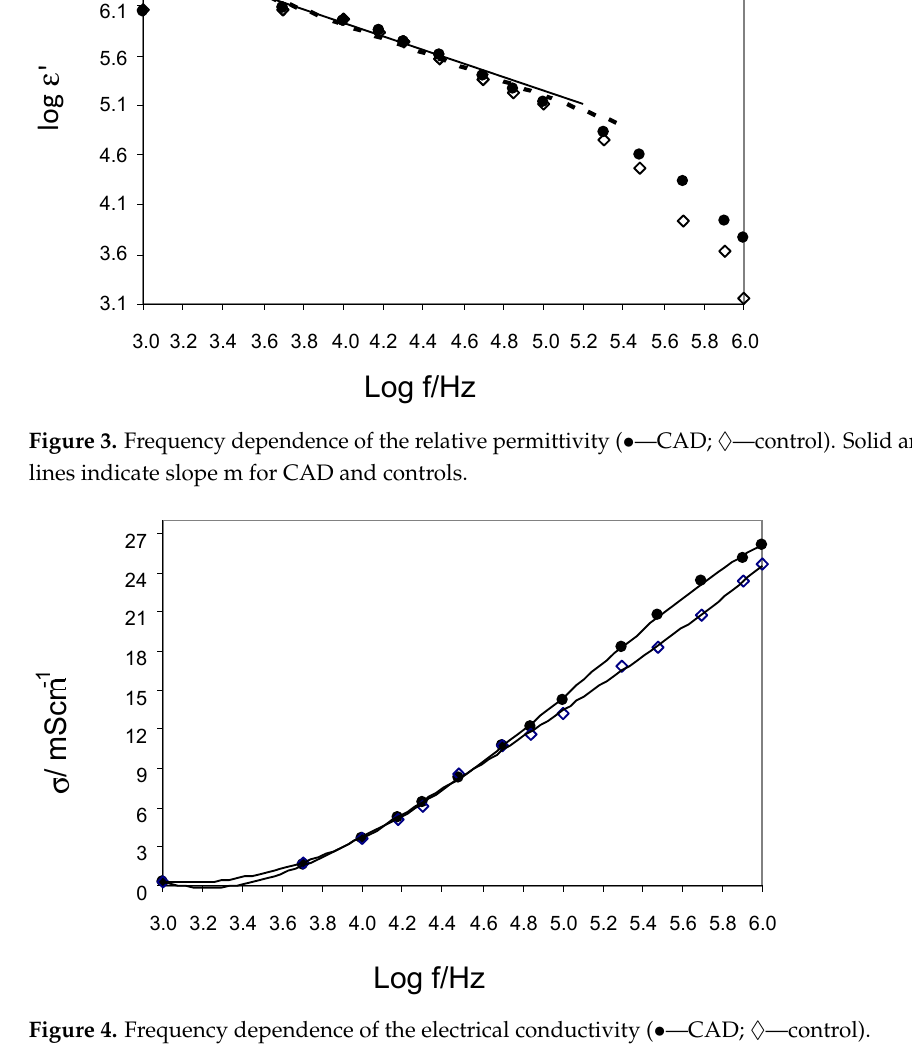
Figure 4. Frequency dependence of the electrical conductivity ( ● —CAD; ◊ —control).